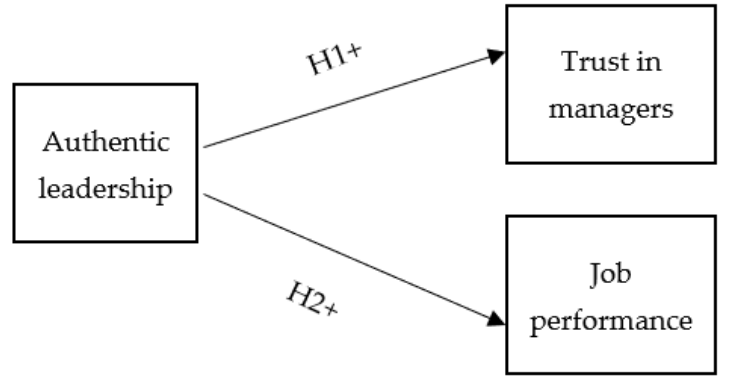
Figure 1. The hypothesized model.